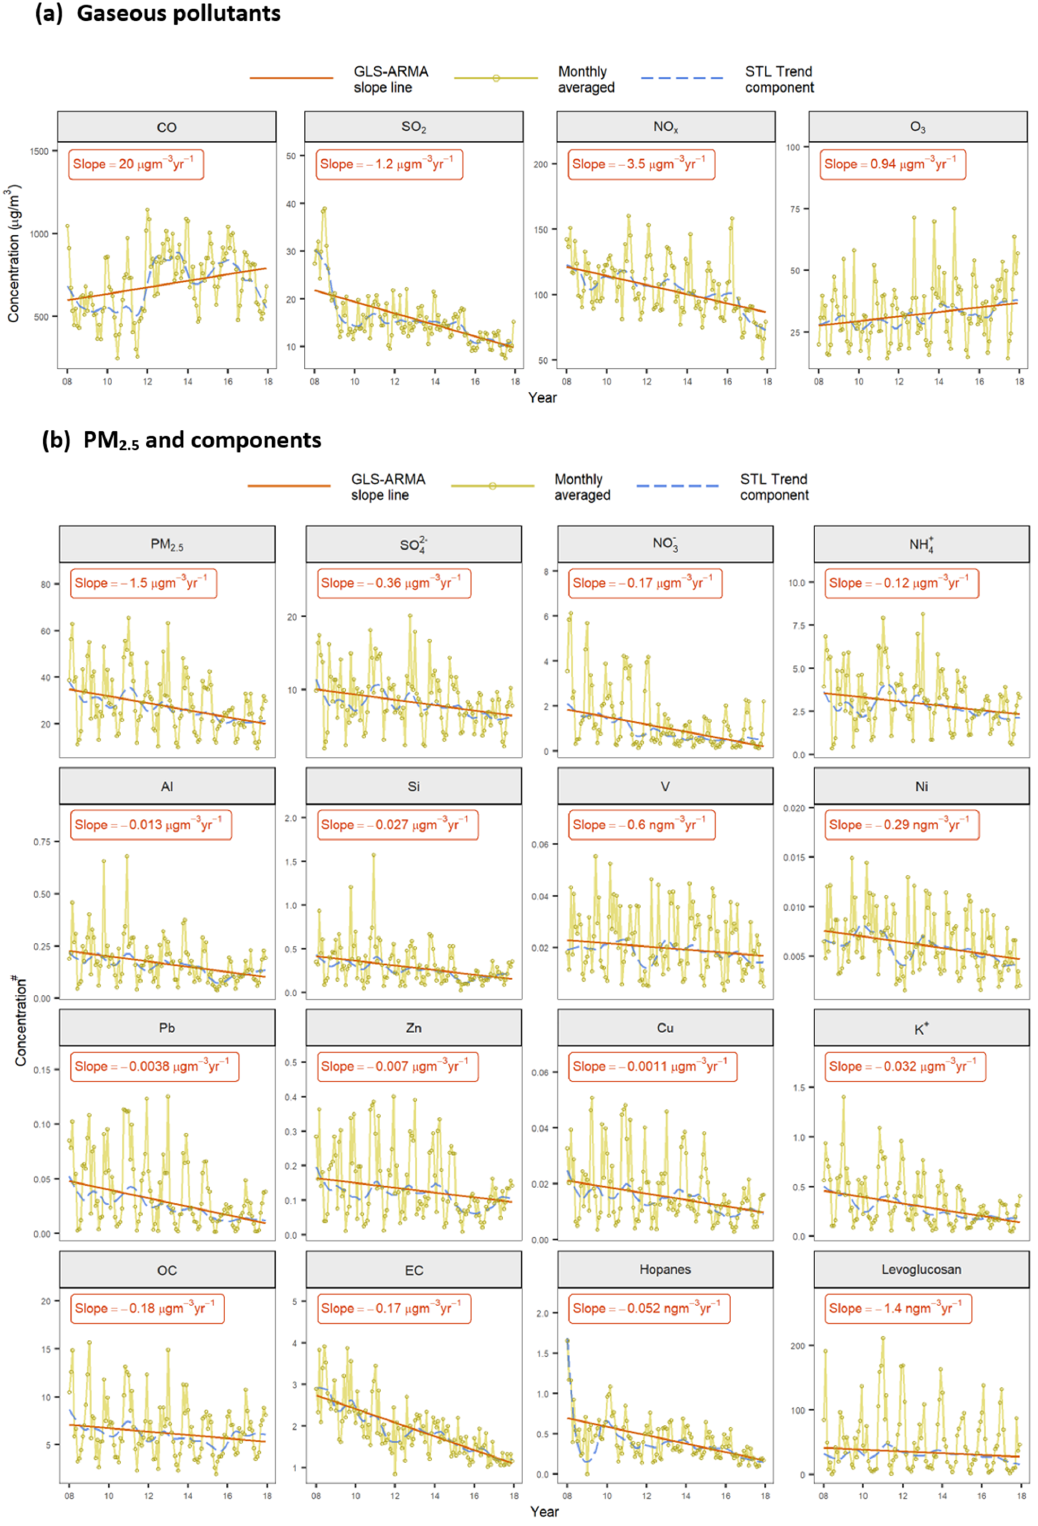
Figure 4. (a) Gaseous and (b) PM 2 . 5 pollutant data over 2008–2017: monthly concentrations (yellow), trend component (blue), and the slope line of trend determined by GLS-ARMA method (red). Note that the concentrations of hopanes and levoglucosan are in nanograms per cubic meter (ngm − 3 ), while the others are in micrograms per cubic meter (µgm − 3 ).